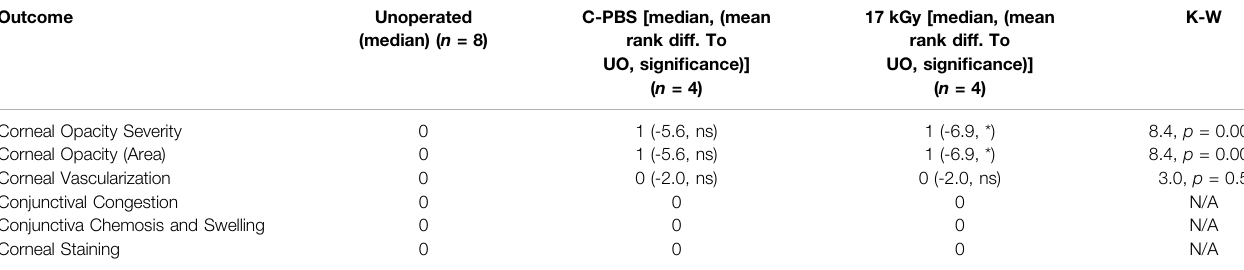
TABLE 3 | Slit lamp evaluation performed at 6 months post-operative. Outcome